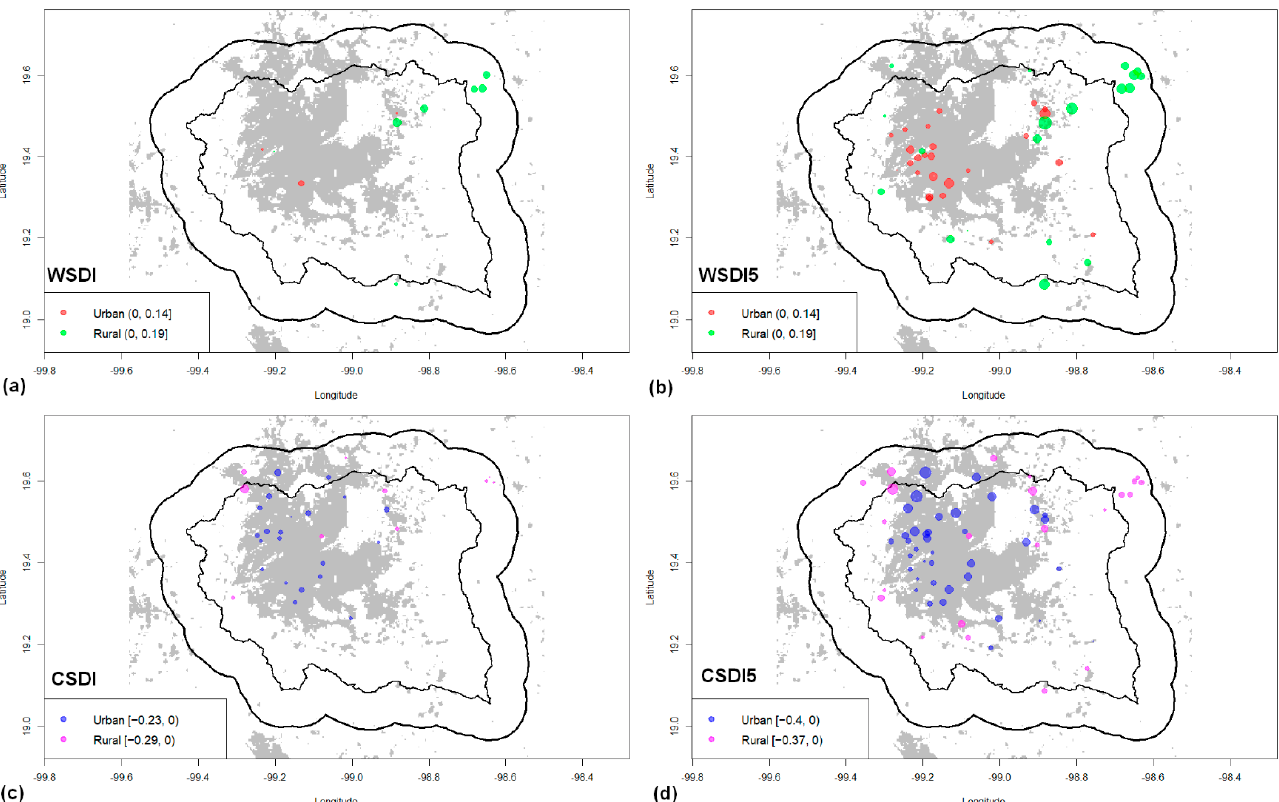
Figure 8. The same as in Figure 5 but for: ( a ) WSDI (days/year), ( b ) WSDI5 (days/year), ( c ) CSDI (days/year), and ( d ) CSDI5 (days/year).